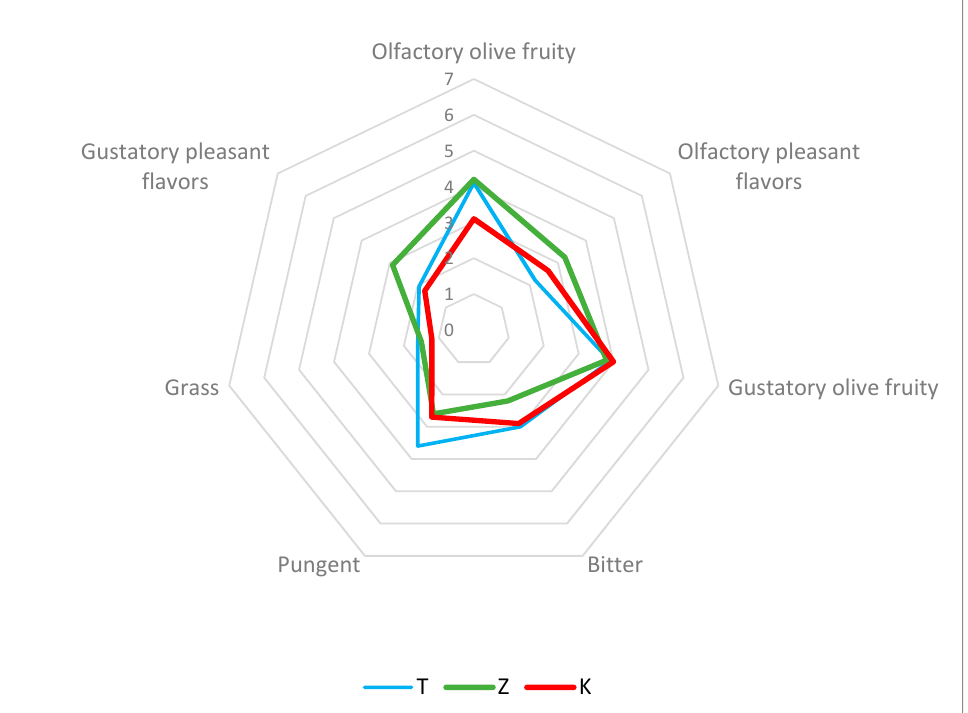
Figure 7. Sensory profiles of olive oils produced by plants treated with CHA-zeolitite (Z), Kaolin (K) and untreated plants (T).